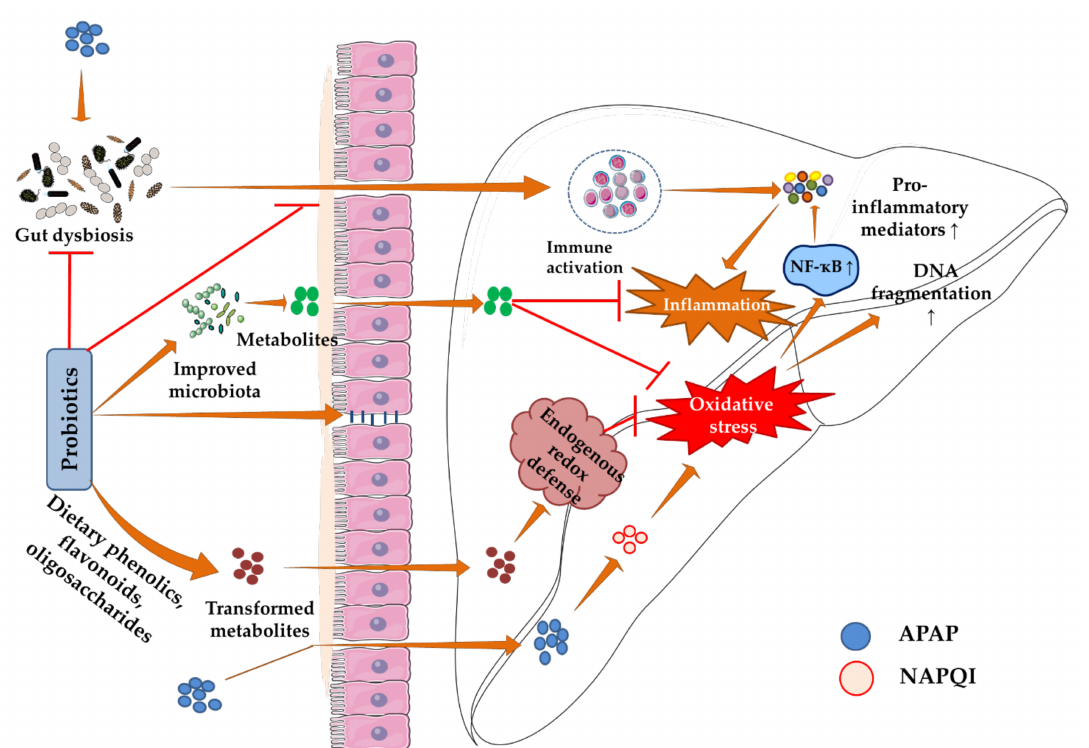
Figure 3. Protective mechanism of probiotics against APAP hepatotoxicity. Probiotics act by altering the composition and activity of the gut flora, resulting in the production of good metabolites that directly reduce APAP-induced oxidative stress and inflammation. Probiotics also attenuate gut dysbiosis, restore intestinal homeostasis, and gut barrier integrity, as well as prevent bacterial translocation to the liver that causes immune hyperactivation. In addition, they produce transformed metabolites (postbiotics) using dietary phenolics, flavonoids, and oligosaccharides, which can activate Nrf-2 and other antioxidant genes that suppress oxidative stress. Brown arrows represent downstream events. Red lines represent inhibition and ‘ ↑ ’ represents upregulation. APAP: acetaminophen, CYP2E1: cytochrome P450 2E1, NF- κ B: nuclear factor kappa-light-chain-enhancer of activated B cells, Nrf-2: nuclear factor erythroid 2–related factor